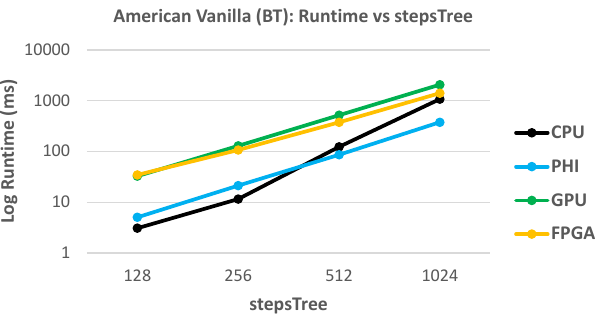
Figure 6. American Vanilla (BT): Runtime vs. number of steps in the BT, for the four target platforms. The solution, then, is to first search for possible optimization opportunities at